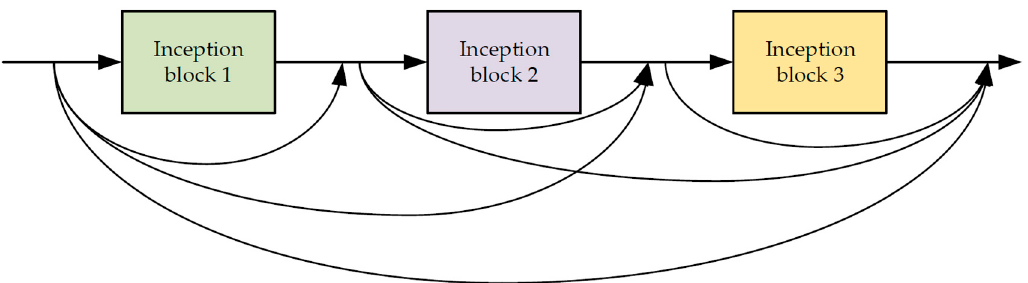
Figure 4. The dense connection of three inception blocks.